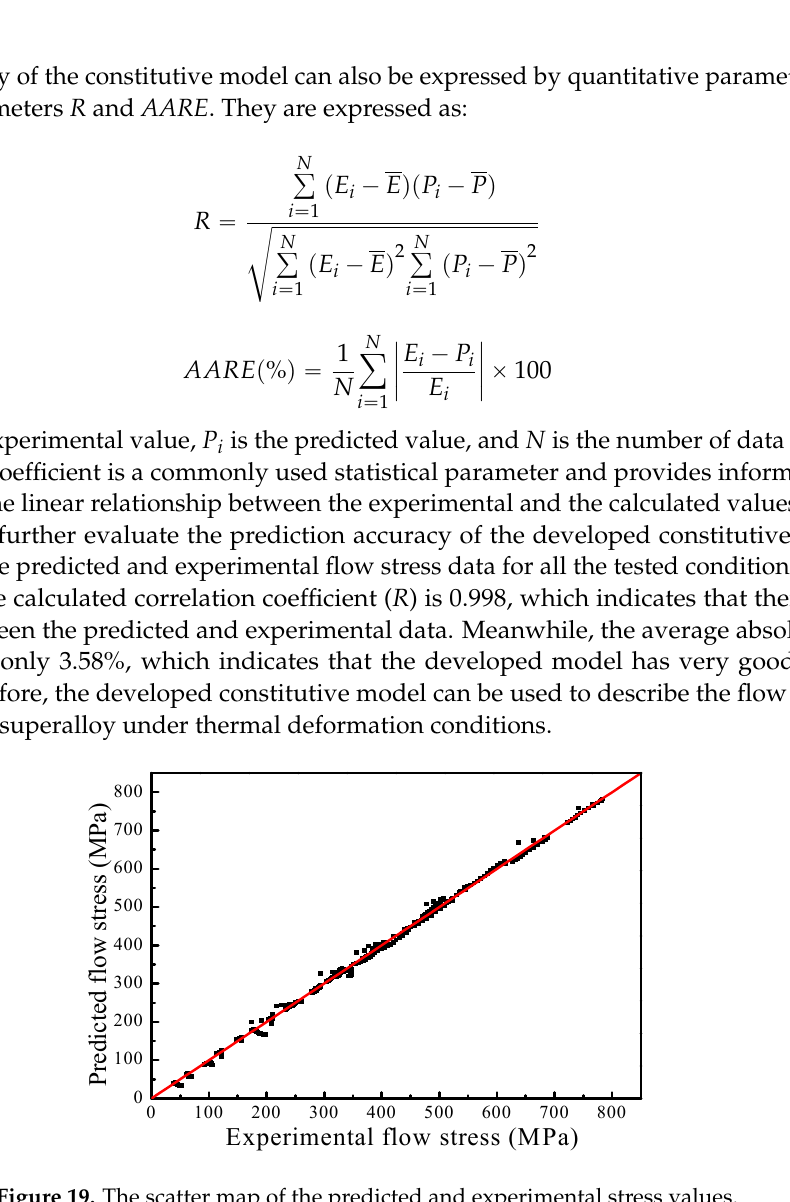
Figure 19. The scatter map of the predicted and experimental stress values.